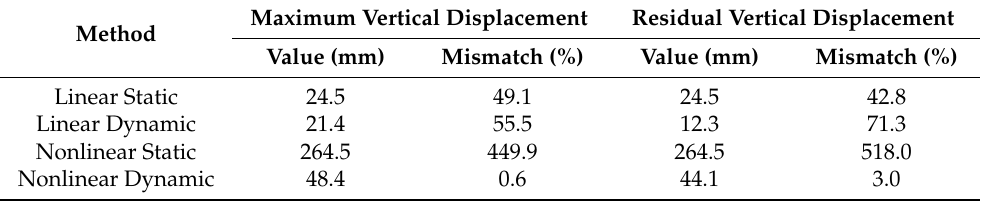
Table 2. Vertical displacements obtained from numerical simulations for point P3_11V. Method